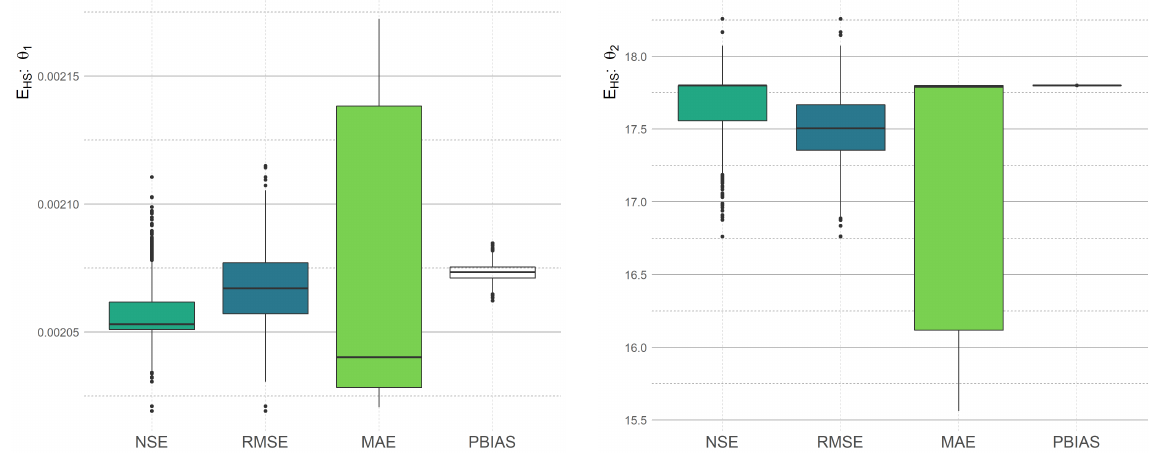
Figure 6. The comparison of the calibrated Hargreaves–Samani model parameters obtained by the cross-validation calibration process on training data with respect to various statistical measures.